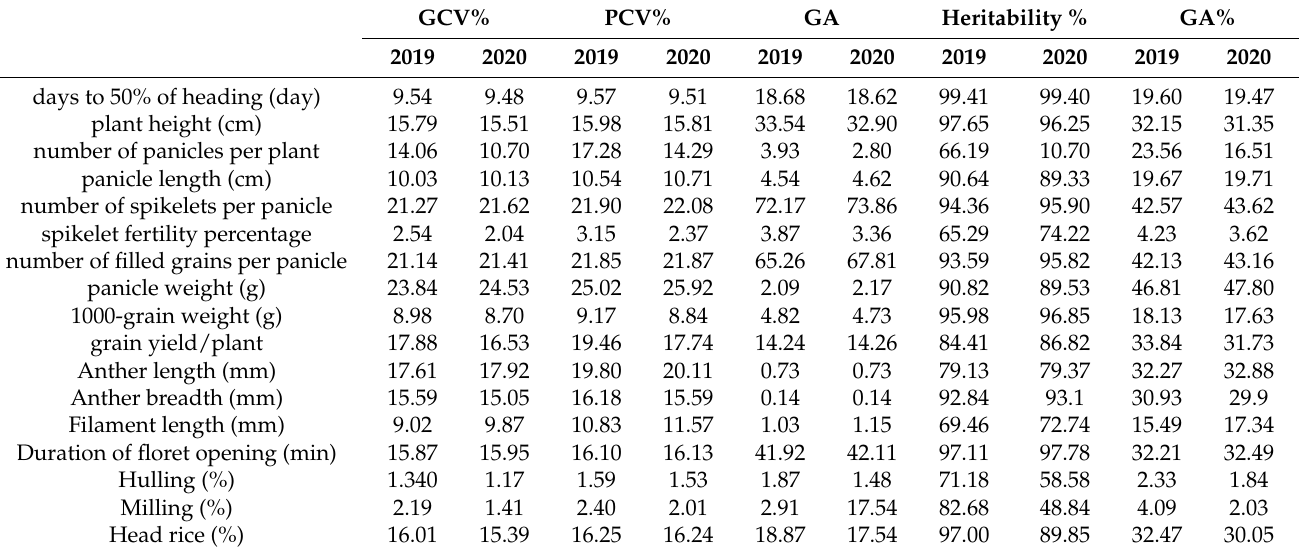
Table 3. Estimates of variability parameters for some agronomic and grain quality traits in rice lines over two years. GCV% PCV% GA Heritability